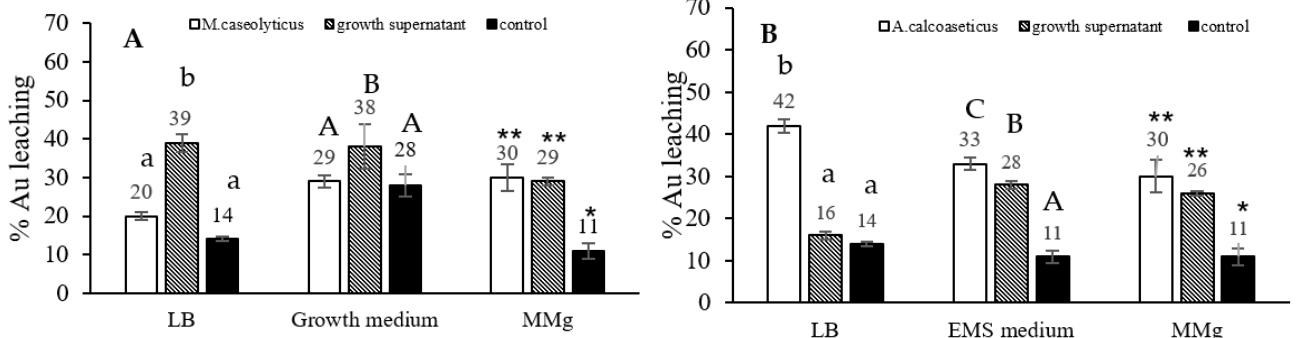
Figure 3. Bioleaching of gold from silicate ores under various media by ( A ) M. caseolyticus and ( B ) A. calcoaceticus under microorganisms and growth supernatant conditions for 7 days. Luria Bertani (LB), minimal medium with glucose (MMg), ethanol mineral salt (EMS), and growth medium. Data were expressed as the mean ± SD ( n = 3). The lower case letters, capital letters, and asterisks (*) were compared to the effect of various media on gold bioleaching by M. caseolyticus and A. calcoaceticus under microorganism and growth supernatant conditions (control: LB/growth medium/minimal medium/ethanol mineral salt medium). Data were analyzed by Duncan’s test ( p < 0.005).